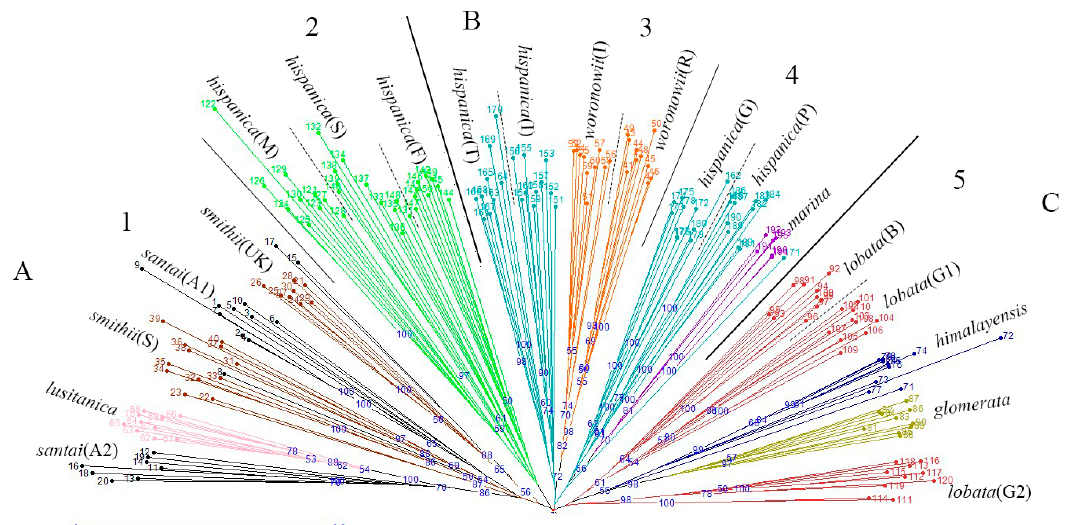
Figure 1. Neighbor-jioning dendrogram of 196 individuals of 20 accessions (nine D. glomerata subspecies), created with Darwin V5.0148. A, B and C mean the 20 accessions could be divided into three groups, and the number 1 − 5 indicate five clusters in accordance with the STRUCTURE analysis results when K = 5.